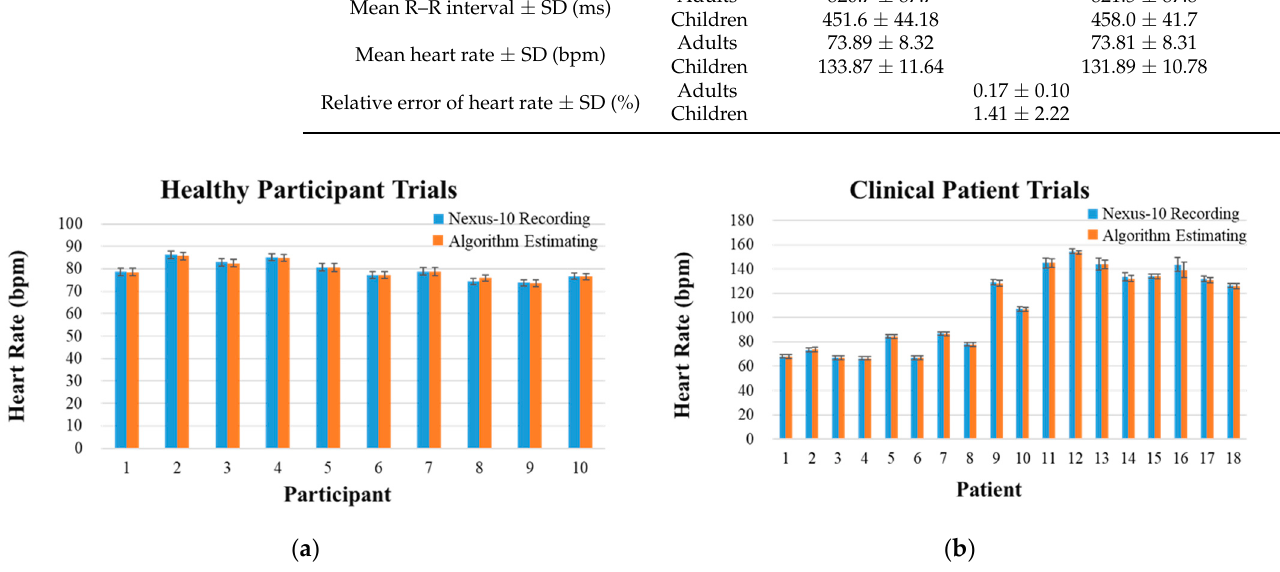
Figure 7. NeXus-10 recording and algorithm estimating values of ( a ) healthy participant trials and ( b ) clinical patient trials for the R-wave detection algorithm. The measurement of HR is represented in beats per minute (bpm). Table 1. R-Wave detection algorithm results (healthy participant).